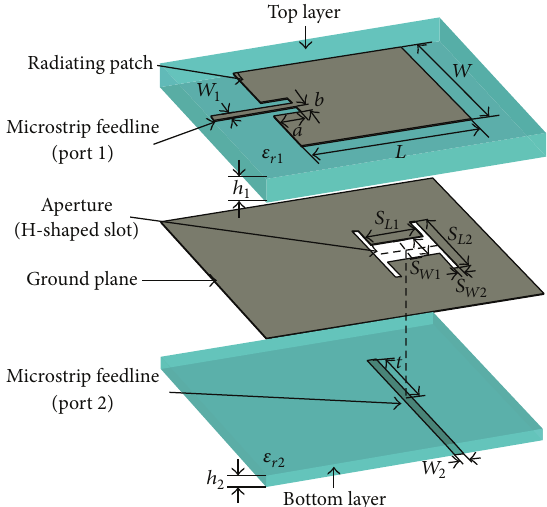
Figure 1: Geometry of a dual-polarized rectangular patch antenna fed by coplanar microstrip line feed and slot-coupled feed.